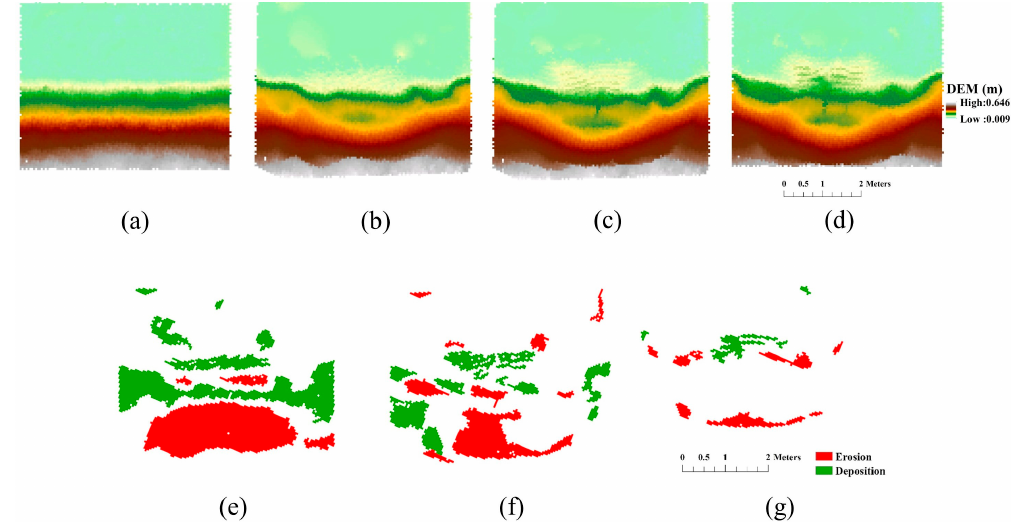
Figure 12. Beach evolution based on CMA analysis and beach models with 5 cm resolution. The upper figures are beach models showing initial model ( a ) and models after one ( b ), two ( c ), and three ( d ) periods of wave application. ( e , f ) show the changing areas of sediment erosion and deposition between consecutive beach models that occurred after one ( e ), two ( f ), and three ( g ) periods of wave application. Each period of wave application lasted 10 min.